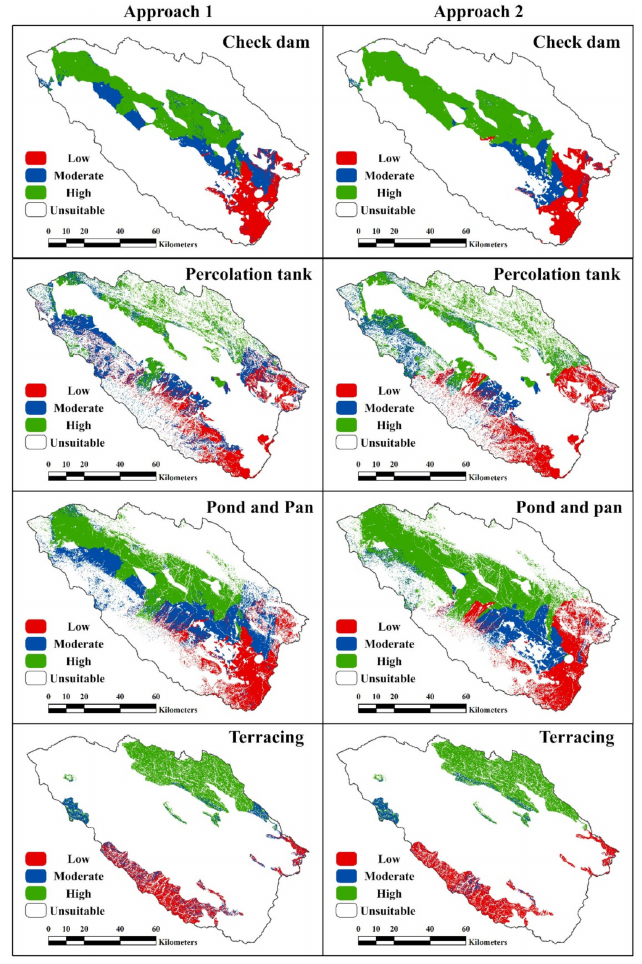
Figure 6. Suitable areas for various RWH techniques, as obtained from the two